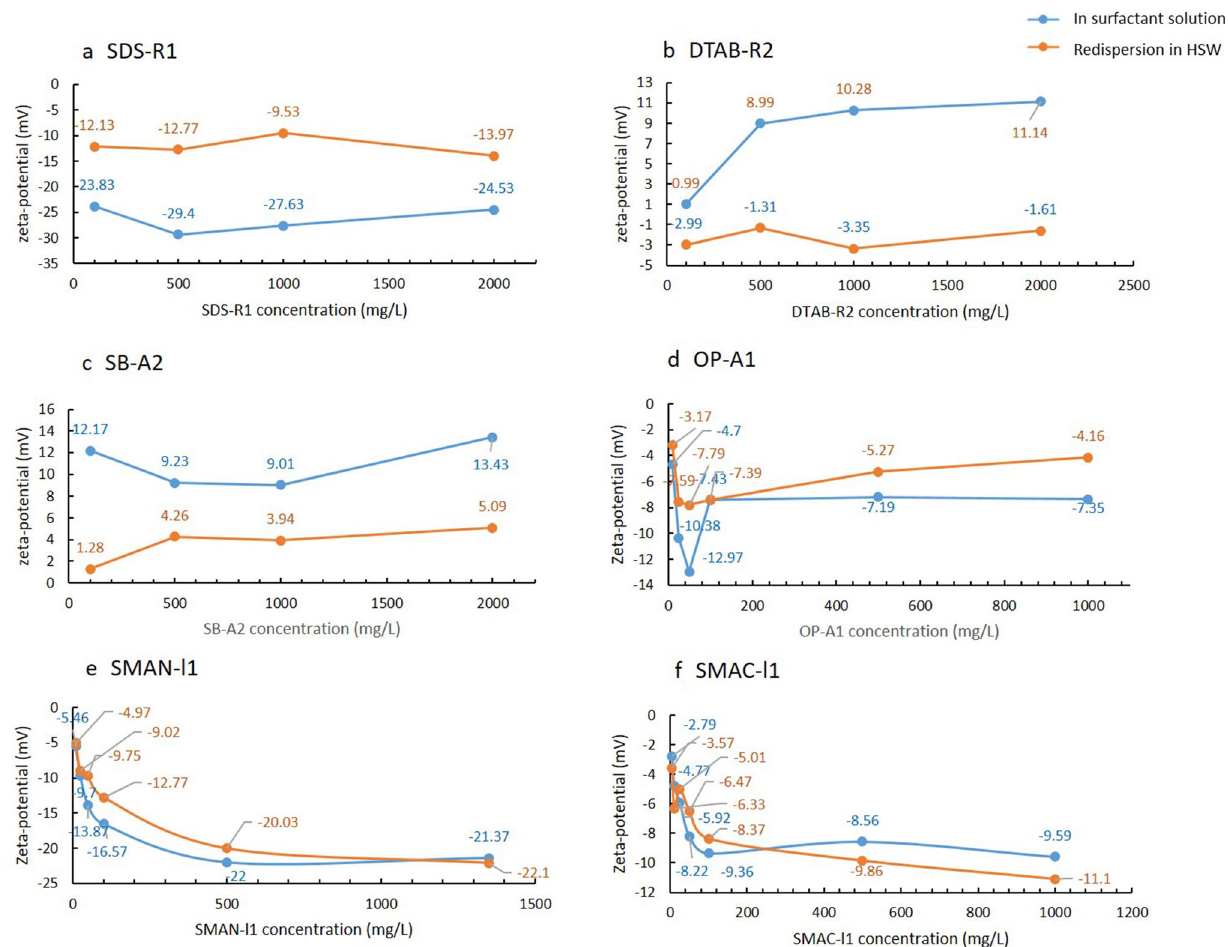
Figure 5. The zeta-potential of calcite particles in the presence of different concentration of surfactants (blue line) and after the surfactant solution is excluded and re-dispersed in HSW (orange